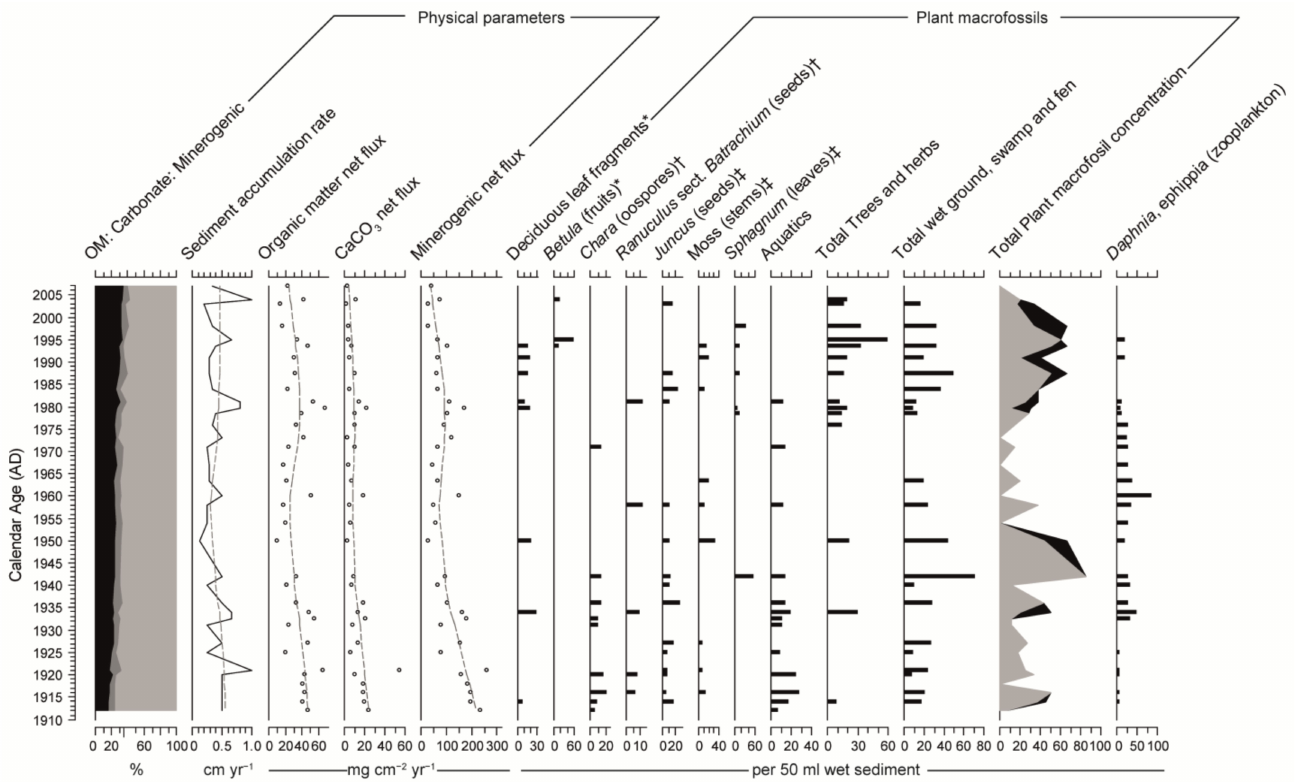
Figure 3. Physical sedimentary parameters and plant macrofossil concentrations (selected taxa) present in the Kilen Kajak sequence. Physical sedimentary parameters refer to sediment accumulation rate, loss-on-ignition (LOI) analyses for percentage organic matter, calcium carbonate (CaCO 3 ), and minerogenic content and flux (with 0.5 span Lowess smoothing) of these parameters based on the 210 Pb/ 137 Cs age–depth model. Plant macrofossil groupings: * = terrestrial taxa, † = aquatic taxa, ‡ = wet ground, swamp, and fen